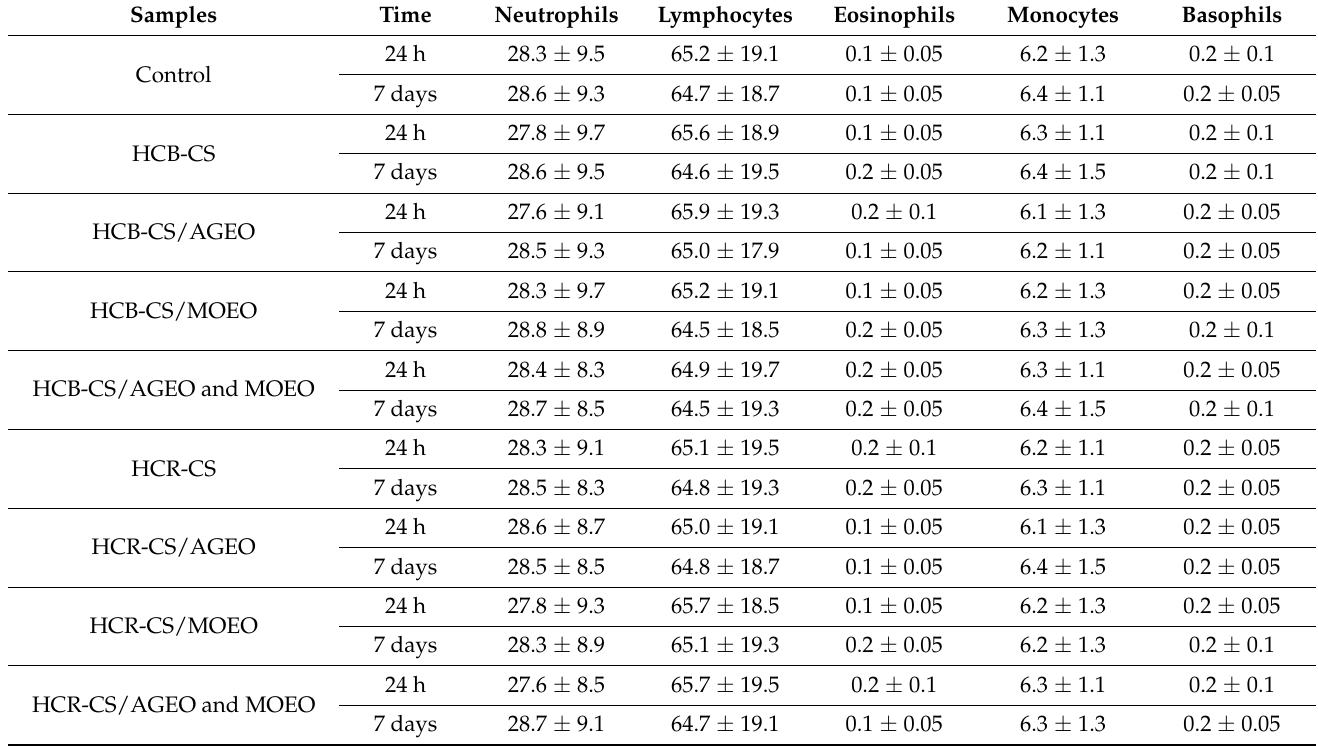
Table 6. Change in cellular composition (%) of leukocytes. Reproduced from Rapa et al. [116] under a Creative Common CC BY